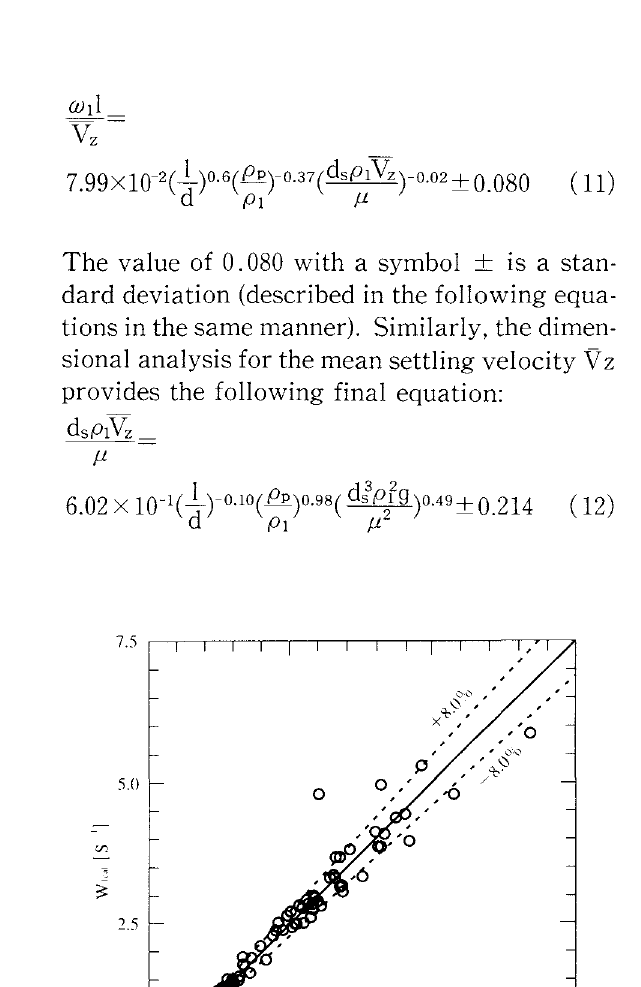
Comparison of values of w1 calculated with those determined experimentally.